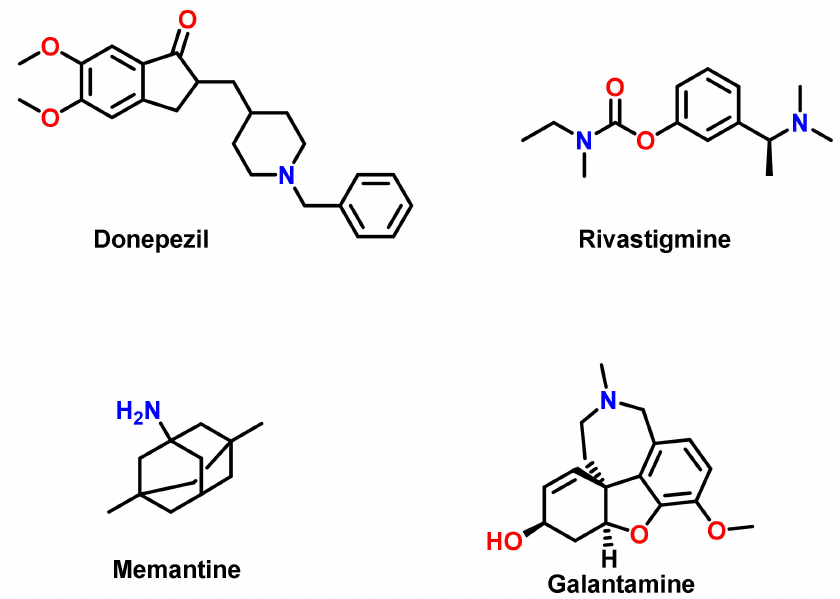
Figure 2. Chemical structures of clinically used drugs for AD.